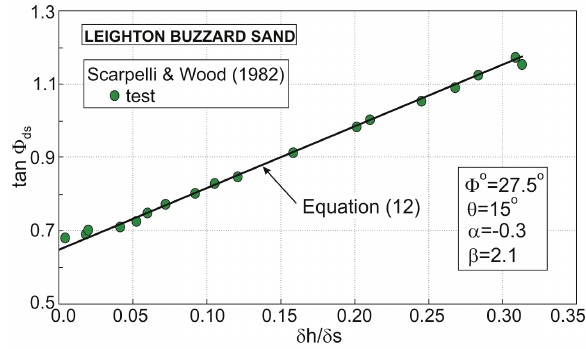
Fig. 9. Relationship between tan  ds and (  h /  s ) for Leighton Buzzard sand tested by Scarpelli and Wood